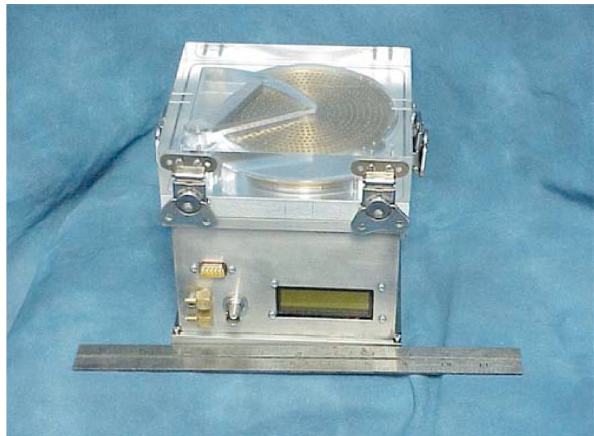
Fig. 1. The existing Time-Resolved Aerosol Collector (TRAC). A Figure 1 12 inch long ruler is set in front for comparison of size in one di-